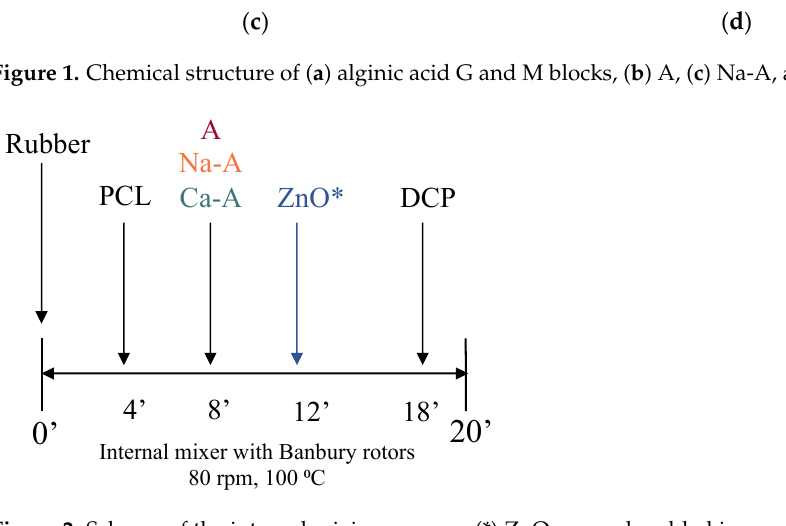
Figure 1. Chemical structure of ( a ) alginic acid G and M blocks, ( b ) A, ( c ) Na-A, and ( d ) Ca-A.